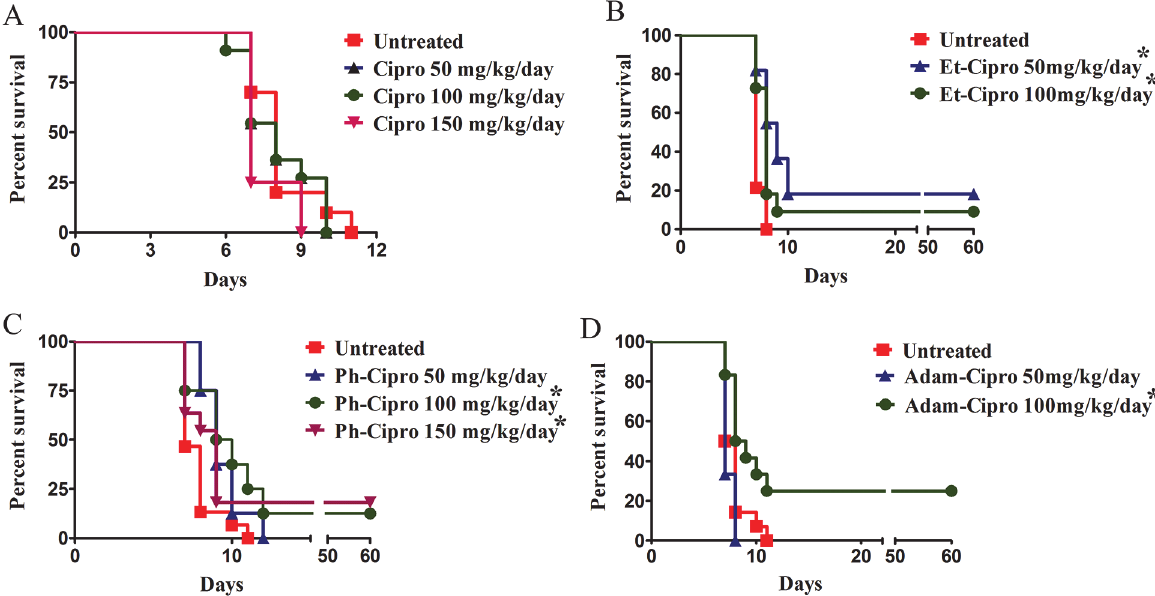
Fig 1. Effect of 7-day treatment with different doses of Cipro derivatives on the survival mice. Swiss Webster mice were infected i.p. with 5x10 3 tachyzoites of T . gondii (RH strain) one day prior to the start of treatment. Results were evaluated by the Kaplan-Meier product limit method, and compared using the log-rank (Mantel-Cox) test. * P < 0.05 vs. untreated controls. The numbers of treated mice in each group were: untreated, 10 (A), 14 (B and D) and 15 (C); 50 and 100 mg Cipro, 11 (three groups each); 150 mg Cipro, 8 (two groups); 50 and 100 mg Et-Cipro, 11 (three groups); 50 and 100 mg Ph-Cipro, 8 (two groups); 150 mg Ph-Cipro, 11 (three groups); 50 mg Adam-Cipro, 3 (one group); 100 mg Adam-Cipro, 12 (three